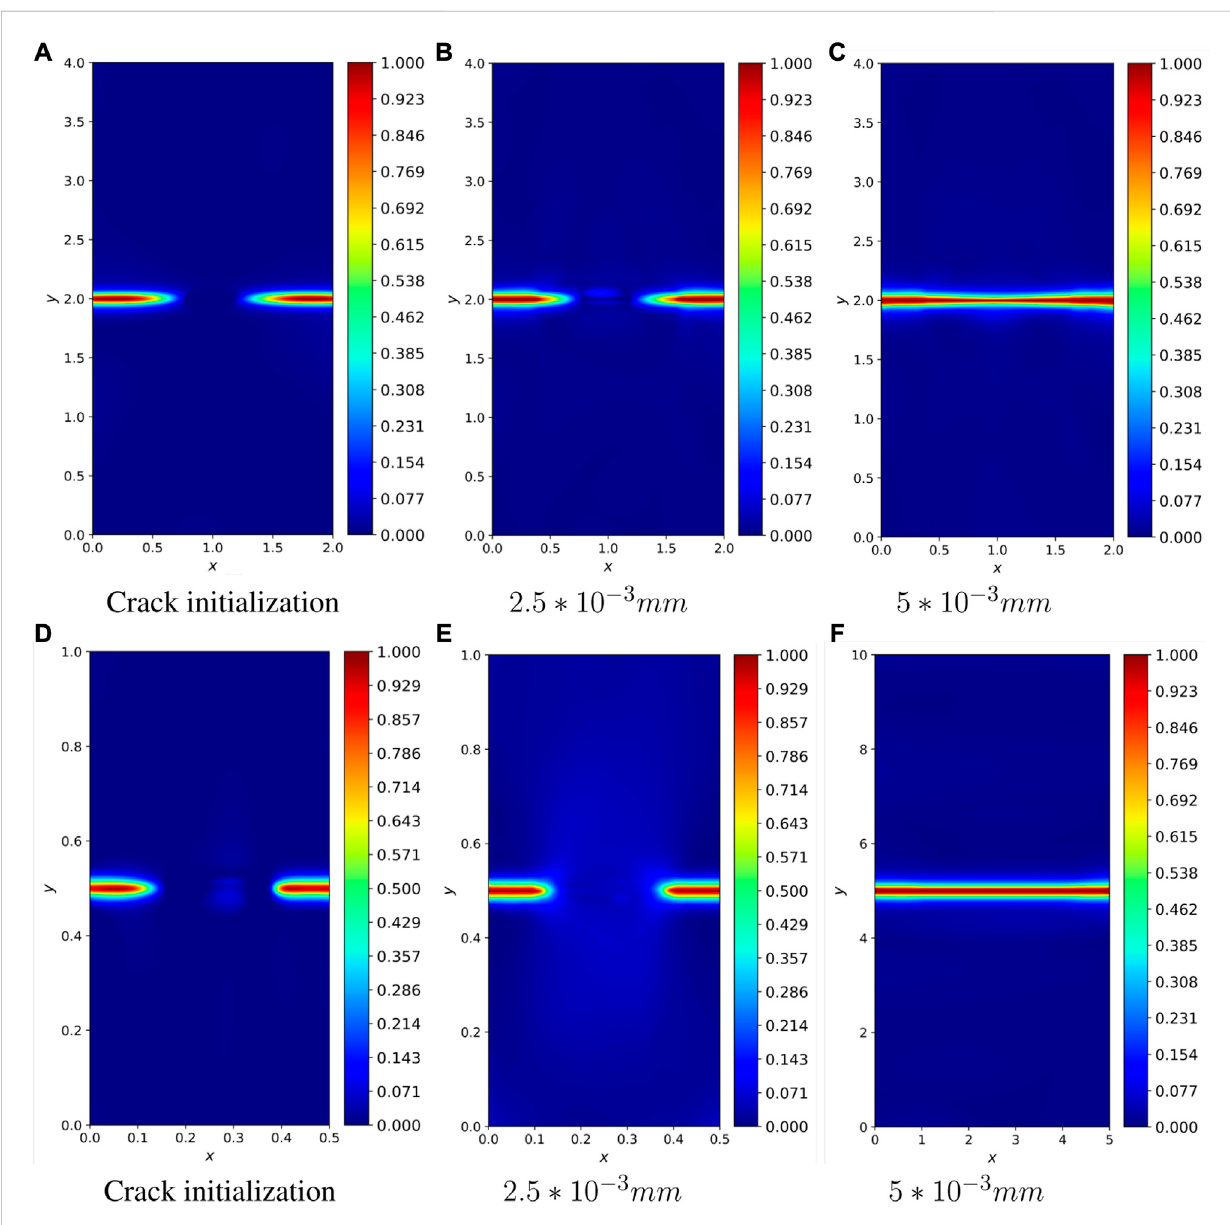
FIGURE 12 Phase fi eld images of Symmetric double notched plates with 4 and 10 times of model enlargement while maintaining the peak stress unchanged. The upper half: